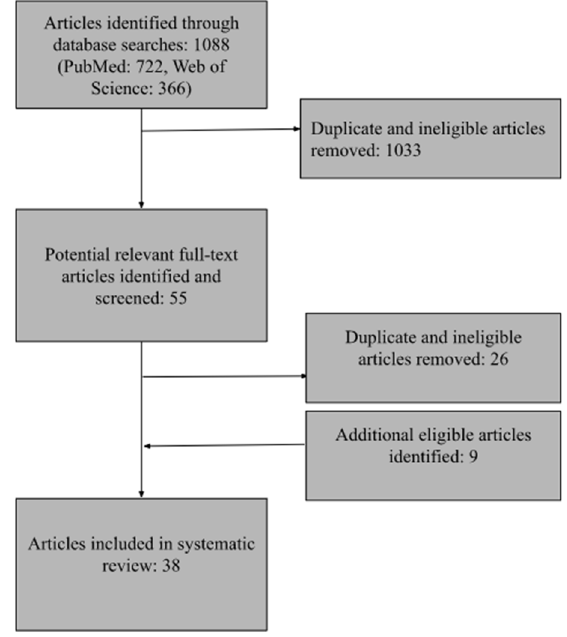
Figure 1. Flow of studies into review.